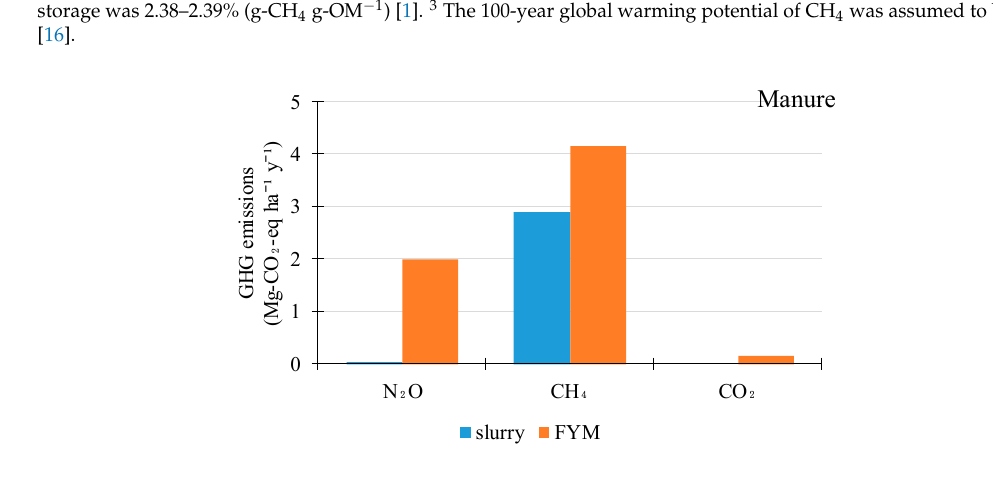
Figure 2. Annualized emissions of N 2 O, CH 4 , and CO 2 related cattle waste management.